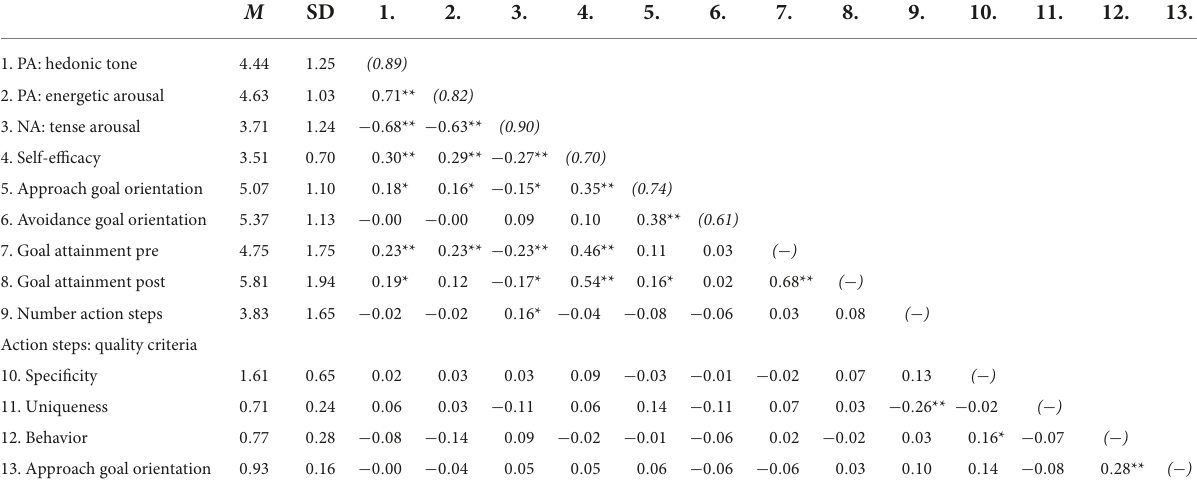
TABLE 2 Means, standard variations, intercorrelations, and reliabilities of the study variables across the three conditions at T1. M SD 1.